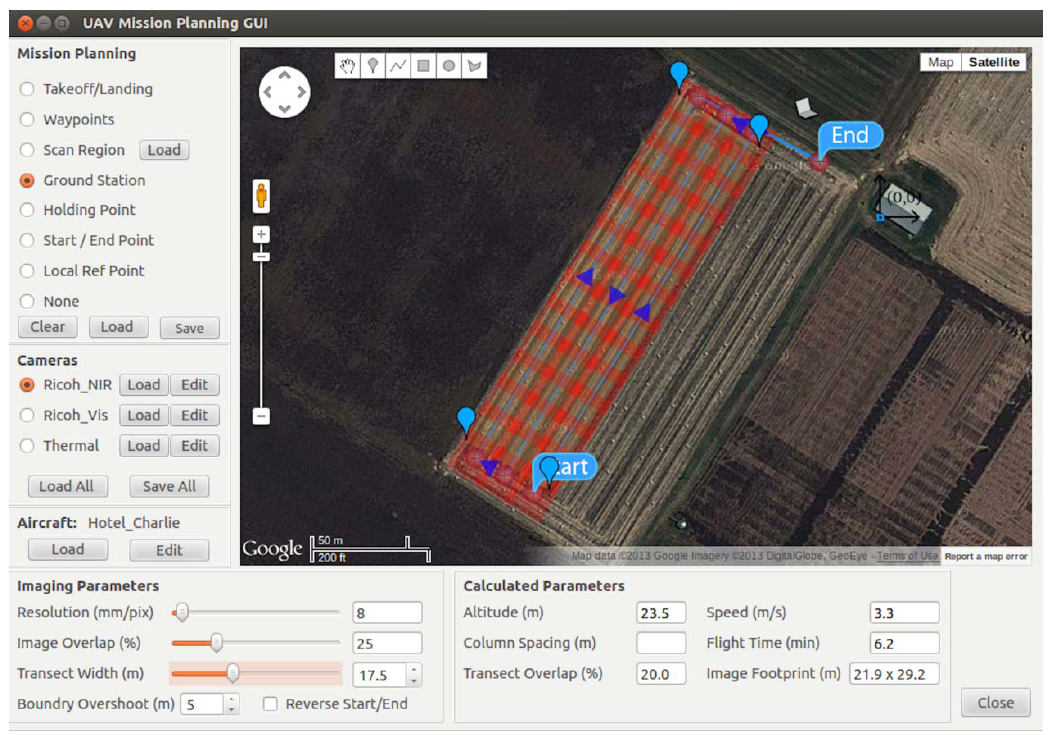
Figure 10. The flight planning tool showing the mission planning information, options to read in camera and aircraft performance specifications and to determine desired imaging parameters for the flight for a region of interest (marked by the user with the blue drop pins). In this case, three passes (arrows) are needed, for the desired resolution is 10 mm/pixel with 25% image overlap (shown in red), a transect width of 10 m and a boundary overshoot of 5 m (to continue